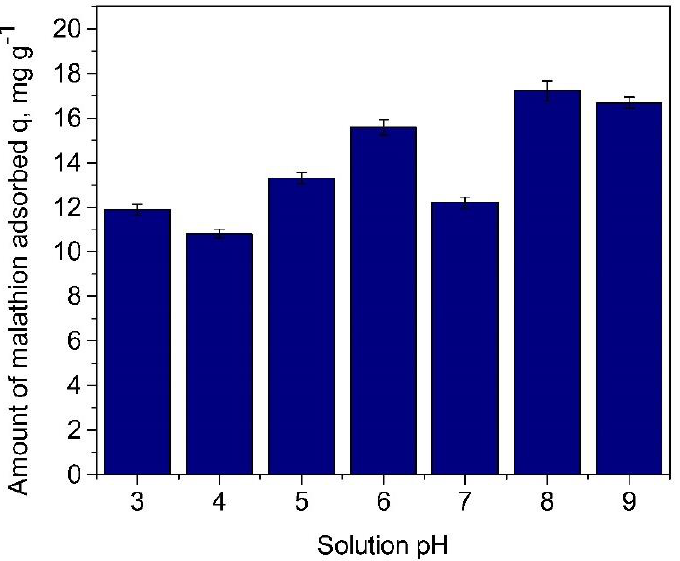
Figure 3. Malathion uptake by SG-LGPS as a function of the pH of the initial solution.